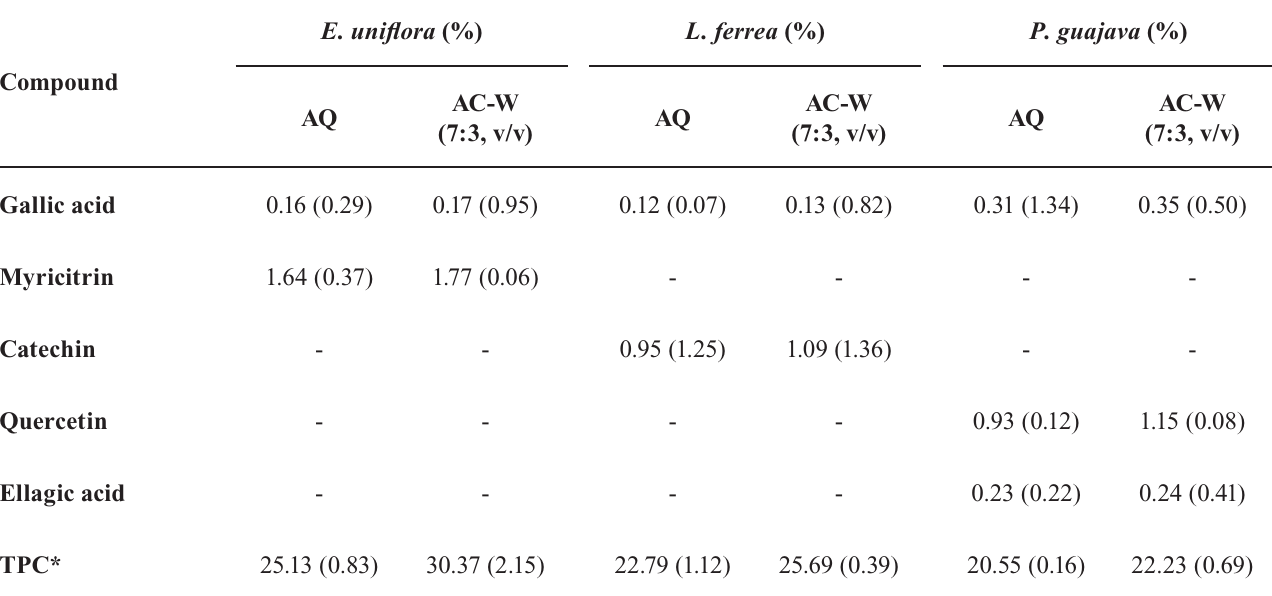
All data represented as mean (relative standard deviation) of three independent measurements. Values are expressed as percentages (µg/g) of each compound in the crude extracts. AQ: Aqueous; AC-W: Acetone:water. *Values expressed as pyrogallol equivalent (PE) per gram of crude